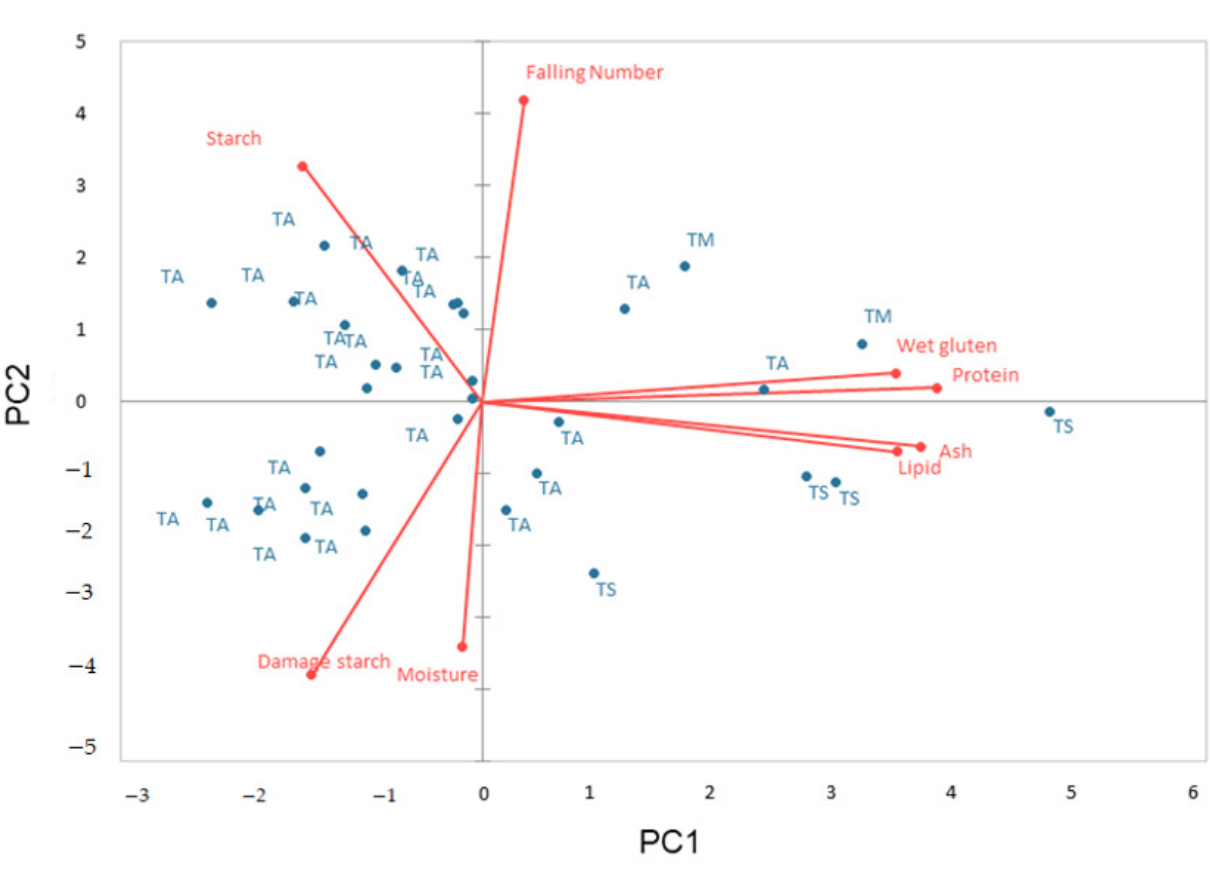
Figure 4. Principal component analysis of the physicochemical characteristics and scores of the wheat samples: TA —Triticum aestivum ; TS —Triticum spelta ; TM —Triticum monococcum .